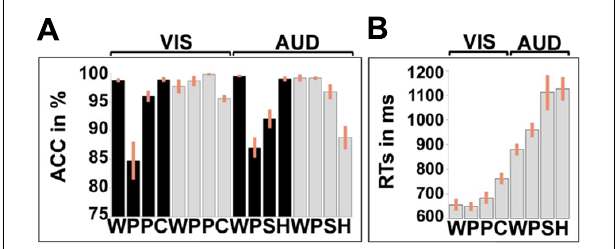
FIGURE 3 | In-scanner performance measures. (A) Accuracy (ACC) in % correct for each of the 16 conditions, averaged over all 25 participants. (B) Response times (RTs) for the one-back-matching tasks for 22 participants (three subjects were excluded because of measurement error). Reaction times were not available for the speech production tasks. Unlike Figure 2 , the bars show the standard error, not the confidence interval. As in Figure 2 , black represents speech tasks, gray represents one-back-matching task.WPPC = word reading, pseudoword reading, picture naming, and color naming stimuli.The second eight columns represent the auditory tasks withWPSH = auditory repetition of words, auditory repetition of pseudowords, naming objects from non-verbal sounds and identifying gender of humming